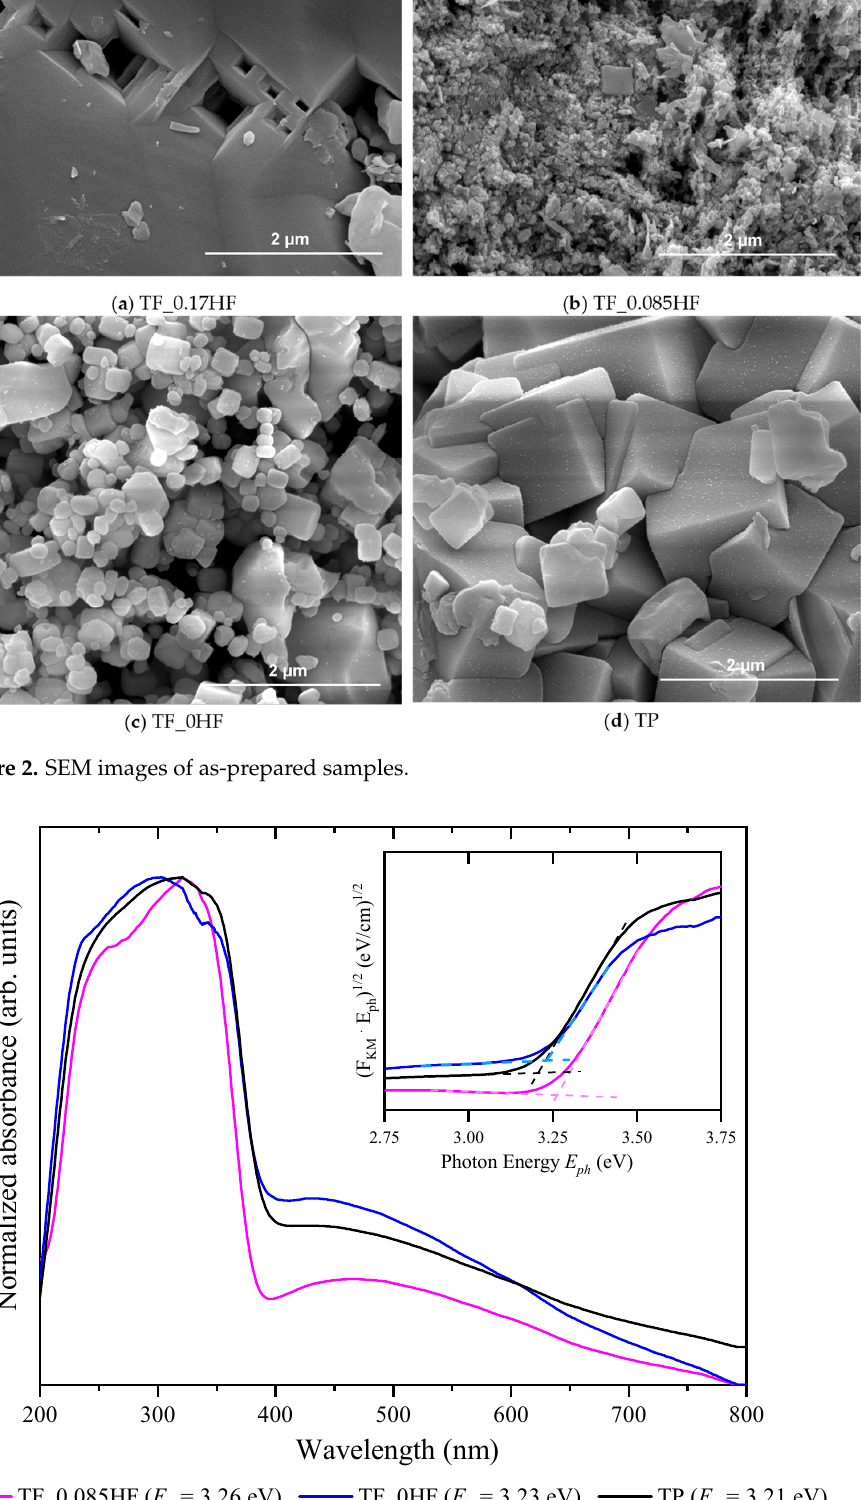
Figure 3. DR/UV-vis spectra of obtained TiOF 2 . The inset shows the transformation of Kubelka– Munk function vs. photon energy.